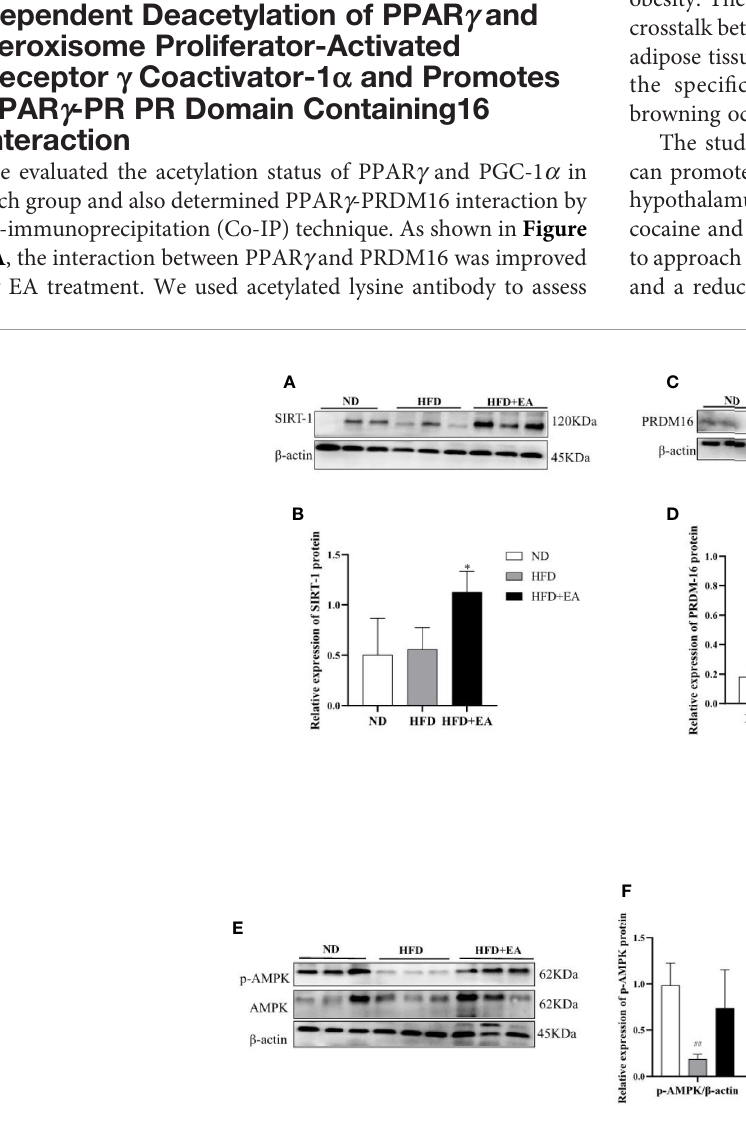
FIGURE 4 | EA increased WAT-browning related proteins in IWAT of HFD + EA group but not in HFD group. SIRT-1 (A, B) , PRDM16 (C, D) , and p-AMPK (E, F) expression in IWAT obtained from ND-fed, HFD-fed or HFD + EA-fed rats following 14 weeks of treatment. Data were represented as mean ± SD (n = 3). ## P < 0.01 vs. the ND group, *P < 0.05 vs. the HFD + EA